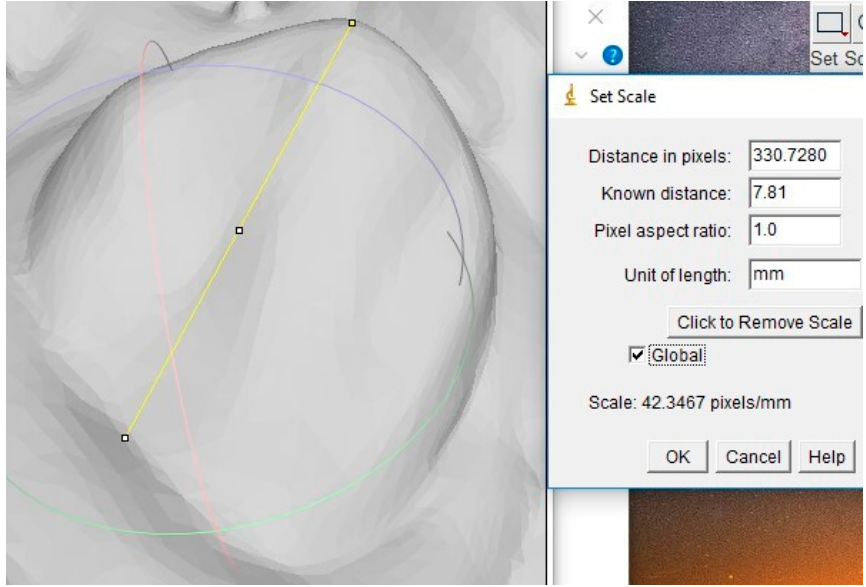
Figure 5. Measurement of the maximum palatal and vestibular length.